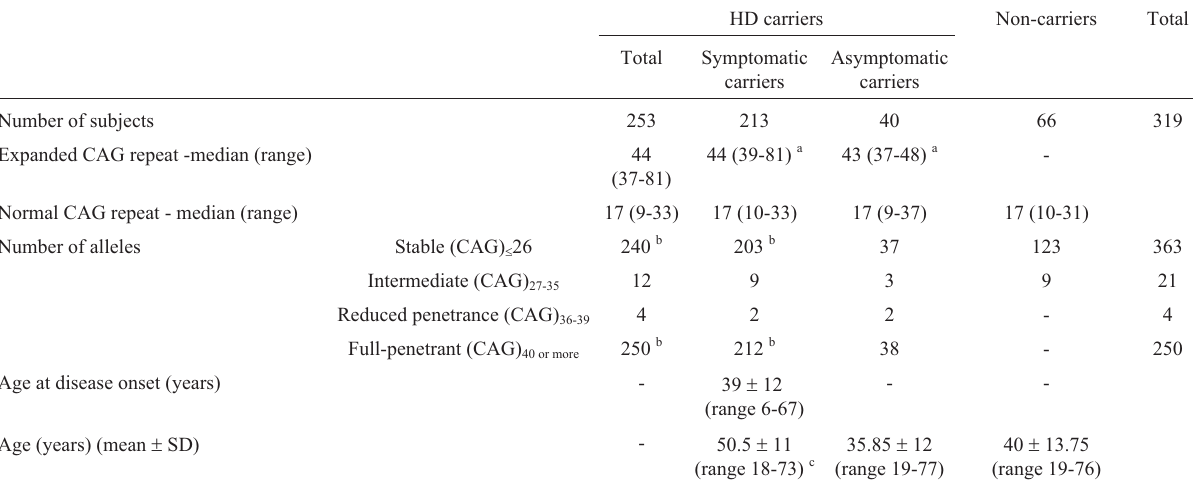
Table 1 - CAG repeat length, allele categories, age at onset and age of participants in the study.